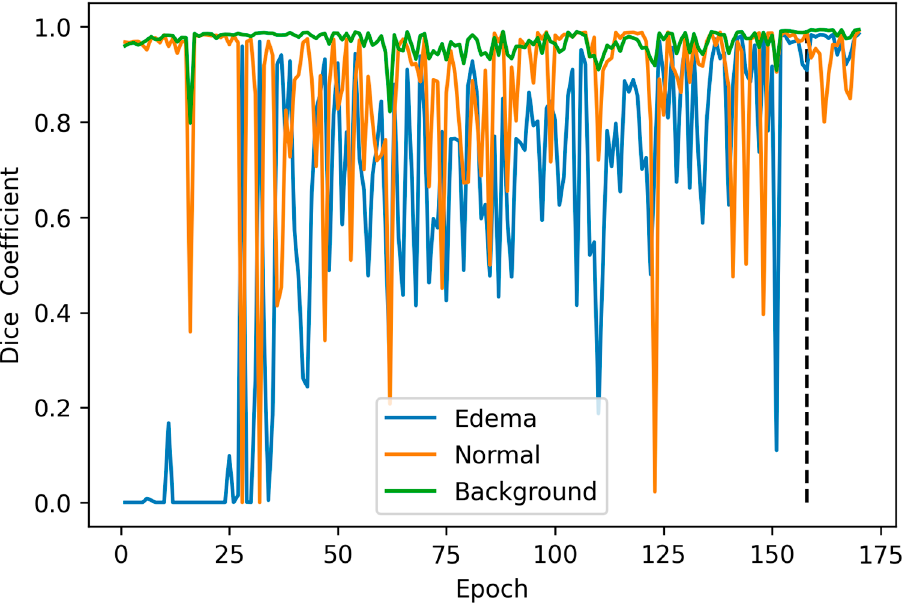
Figure 3. Dice coefficients of the training set of Epi Edema Detector and Stroma Edema Detector during training. The dashed vertical line indicates the end of Epi Edema Detector’s training and the beginning of Stroma Edema Detector’s training.